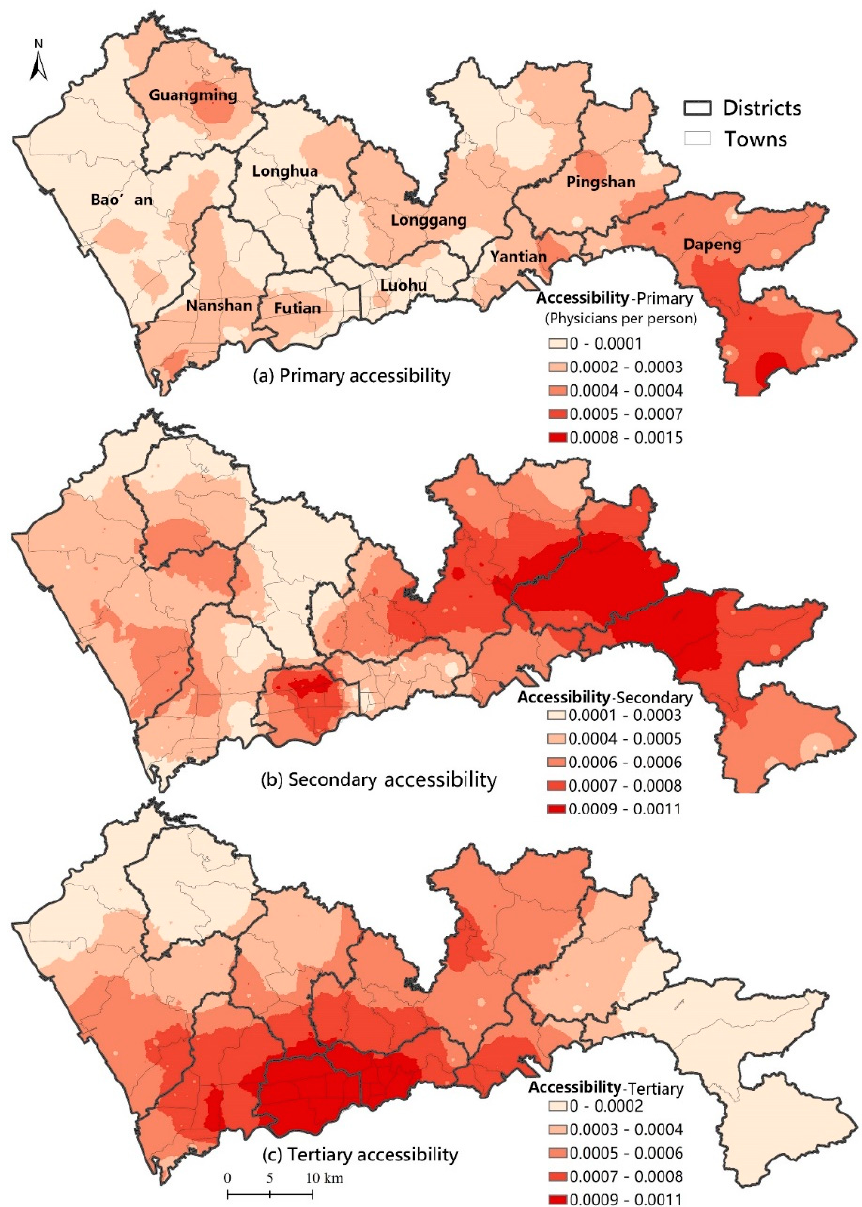
Figure 4. Actual accessibility to hospitals at various levels in Shenzhen. Second, the distributions of healthcare accessibility at different levels are quite dif- ferent. The accessibility to primary facilities is relatively equal across the city, which is also confirmed by the low CV value of 0.228 (Table 2). By contrast, the distribution of accessibility to secondary hospitals is more unbalanced, with a CV of 0.439. It is higher in Futian, Longgang, Pingshan and Dapeng, but much lower in Longhua. The CV of accessibility to tertiary hospitals is 0.542, indicating that the inequality in accessibility to tertiary hospitals is the largest. The accessibility to tertiary hospitals is highest in Futian and Luohu and rapidly decreases outwards. Briefly speaking, the distribution of accessibility to higher-level facilities is unequal, whereas the accessibility to primary facilities is equally distributed but is overall